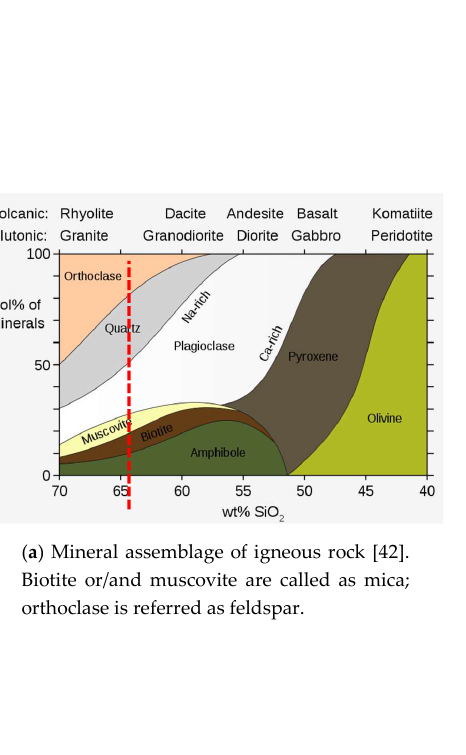
Figure 8. SEM images of dolomite and granite with magnification (note: 1 KX = 1000 X).